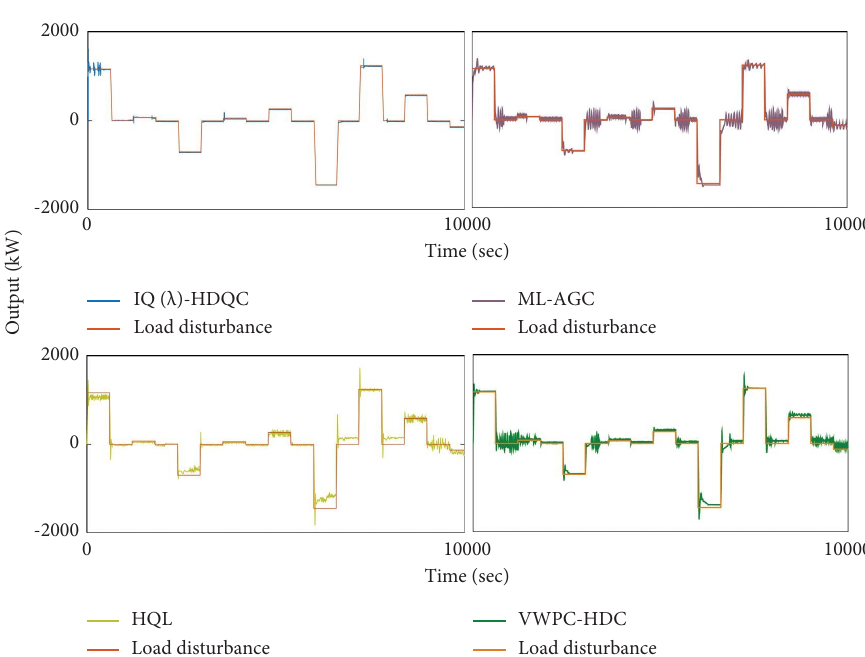
Figure 6: Te output efect of four strategies under square wave